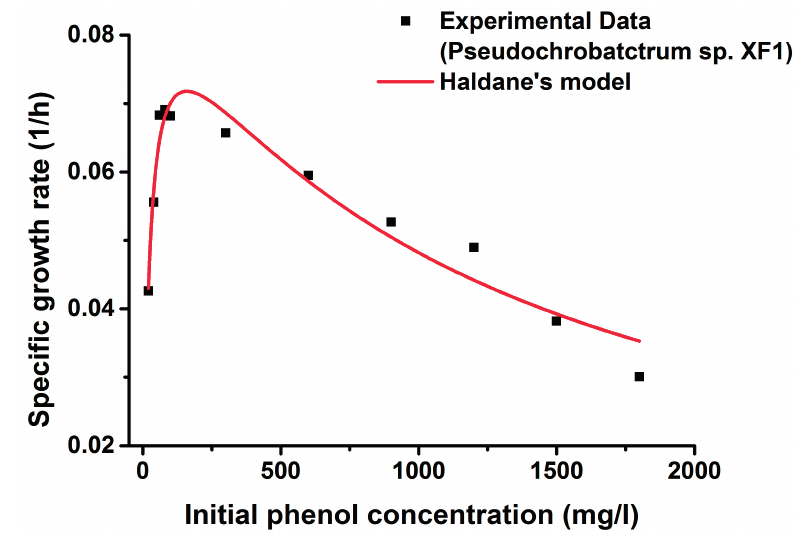
Figure 5. Experimental and predicted specific growth rates of Pseudochrobactrum sp. XF1 using Haldane’s model.